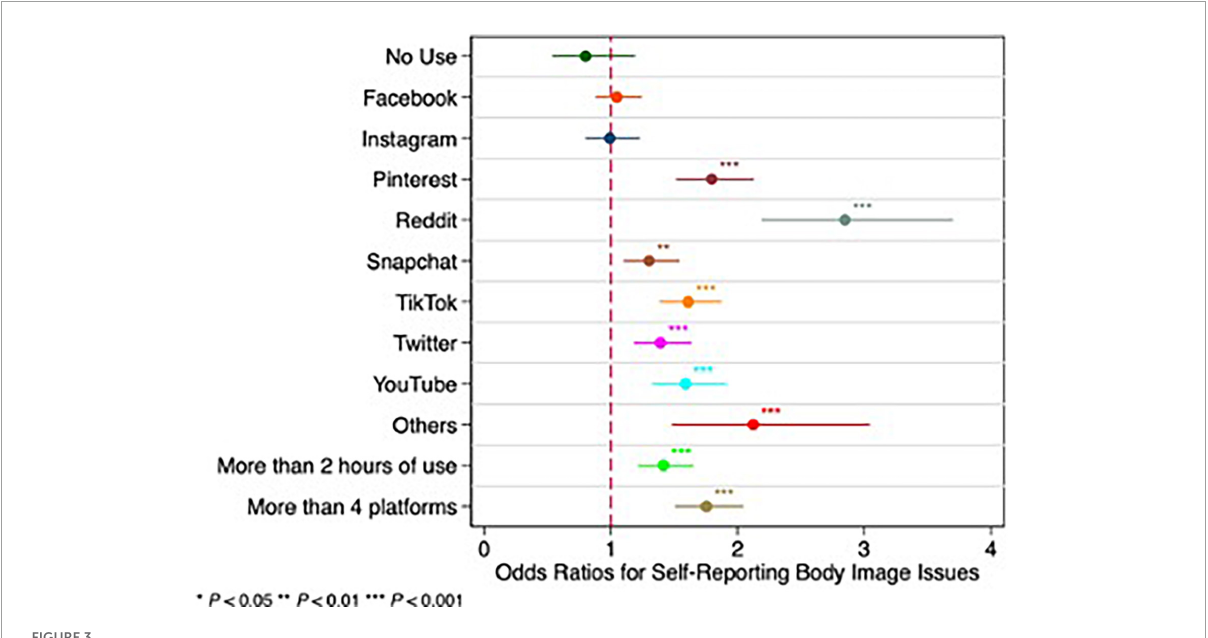
FIGURE3 Odds ratios for self-reporting body image issues (BII) after adjusting for